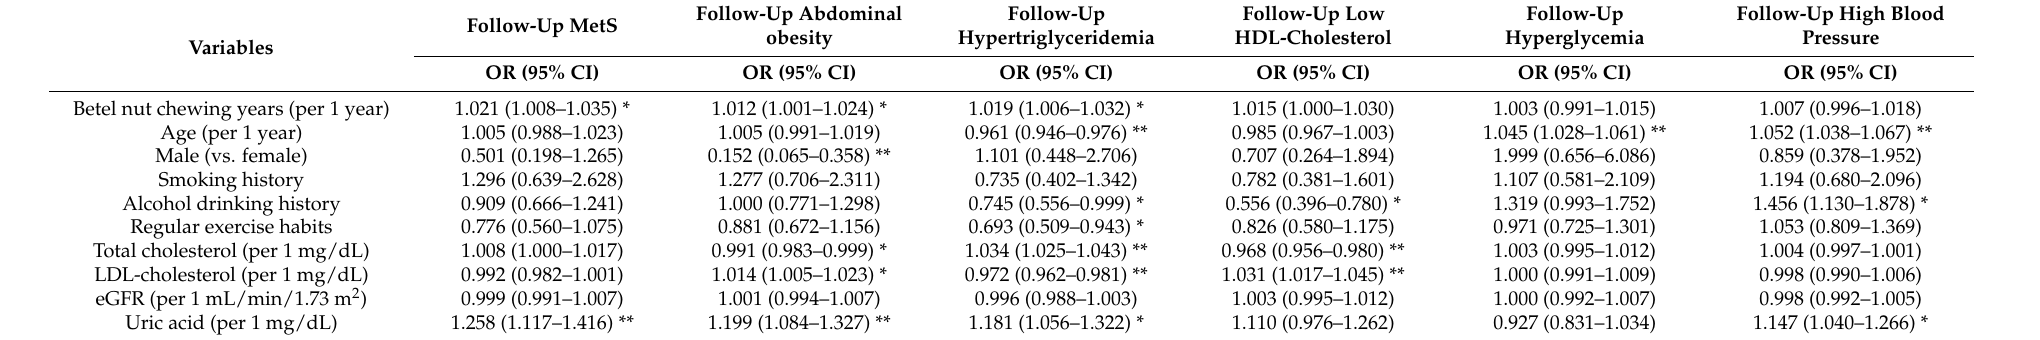
Table 5. Association of betel nut chewing years with follow-up MetS and its components in follow-up participants without baseline MetS with a betel nut chewing history ( n = 1146) using multivariable logistic regression